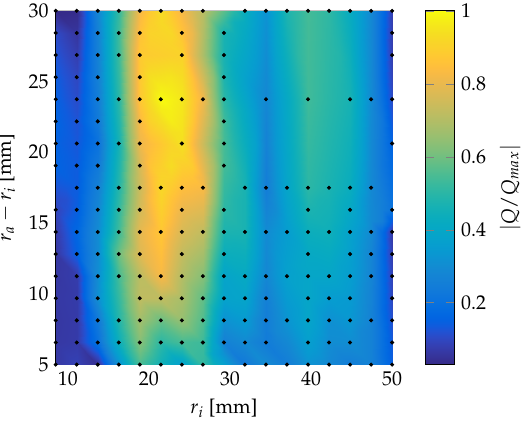
Figure 17. Relative generated electrical charge of a ring sensor with different geometries and a 0.2 mm thickness for a 5 mm diameter actuator and a 10 mm steel plate.